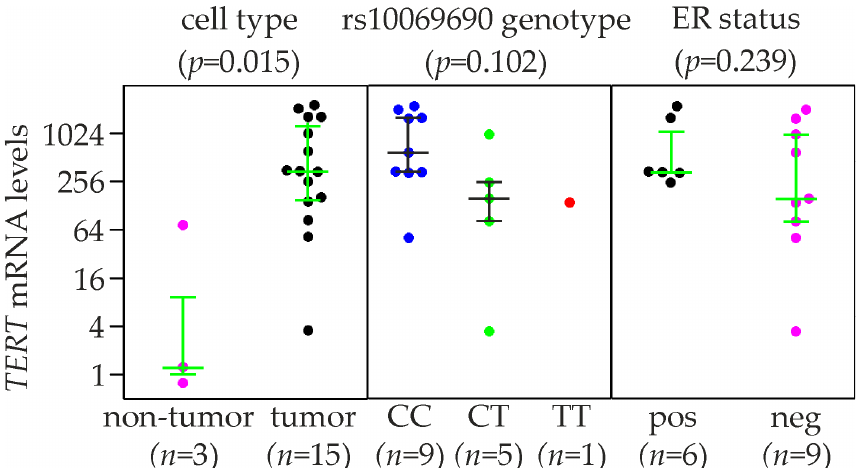
Figure 3. Expression of TERT in 19 cell lines derived from breast tumors and untransformed breast epithelium. Cell lines were stratified by cell type (untransformed mammary epithelial vs. breast cancer cell lines), rs10069690 genotype, and estrogen receptor (ER) status as indicated (the latter two in breast cancer cell lines only). MCF-10A had by far the highest TERT mRNA levels among the non-tumor cell lines, and Hs 578T by far the lowest among the breast cancer cell lines (Table S2). The y-axes show normalized relative TERT mRNA levels (linear values). The numbers of cell lines in each group ( n ) are shown in parentheses. Horizontal lines indicate the first, second (i.e., median), and third quartiles. Pos, positive; neg, negative. ER status according to [30,31]. p -values ( p , in parentheses above each panel) were determined by Kruskal-Wallis